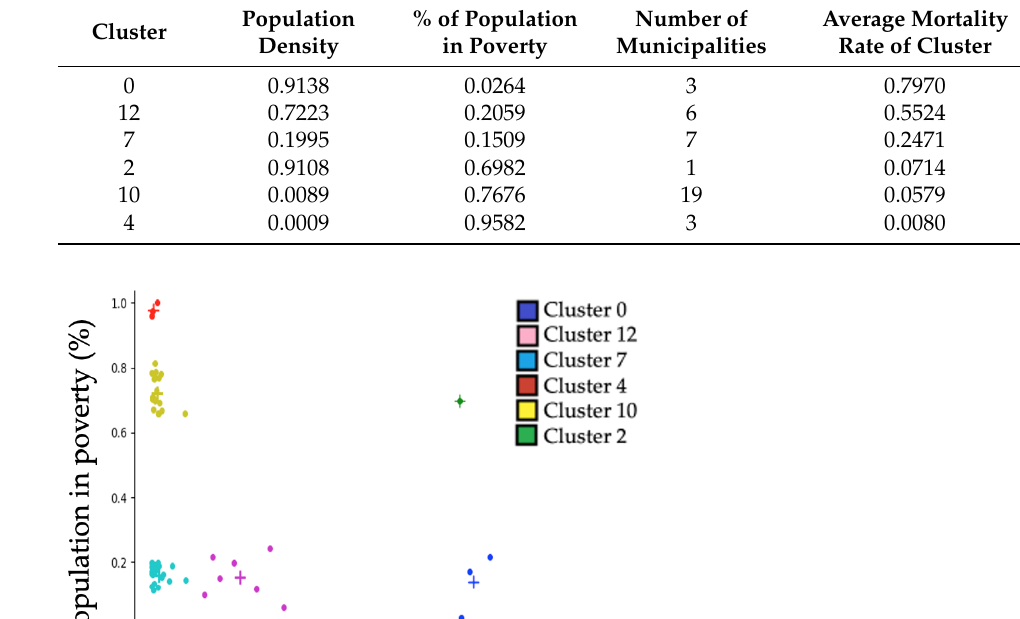
Table 5. Extreme clusters.